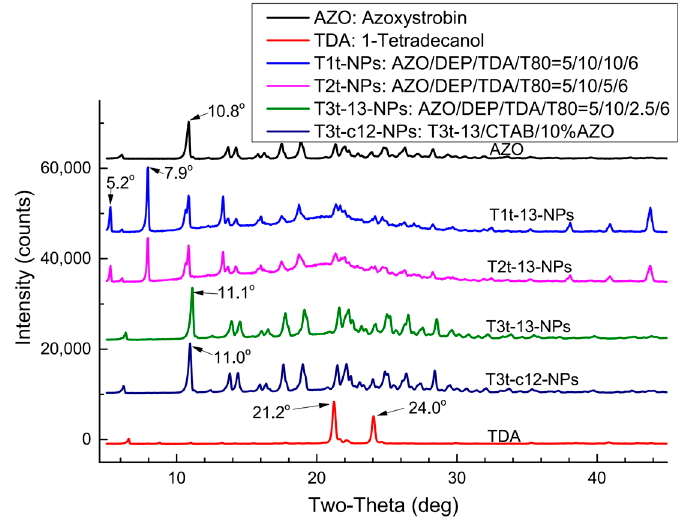
Figure 7. XRD patterns of AZO-TDA-DEP-T80 NPs. AZO and TDA represent the pure components AZO and TDA; T1t-13-NPs, T2t-13-NPs, T3t-13-NPs and T3t-c12-NPs were the dry NPs of T1t-13, T2t-13, T3t-13 and T3t-c12, respectively.